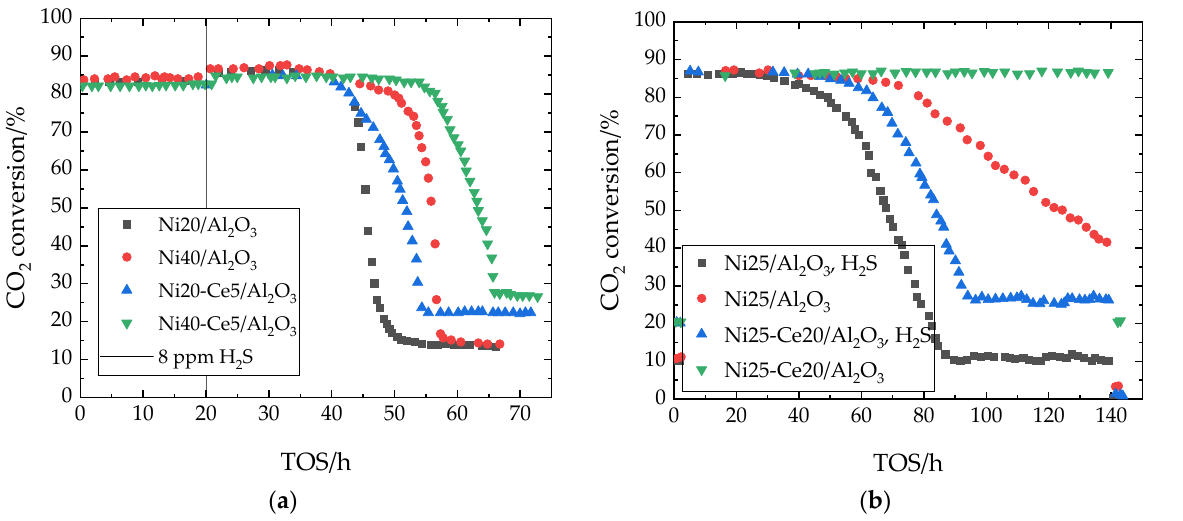
Figure 6. CO 2 conversion in H 2 S poisoning experiments in CO 2 methanation with Ce-promoted Ni/Al 2 O 3 catalysts with ( a ) 5 ppm H 2 S addition after 20 h [60] and ( b ) 1 ppm H 2 S addition compared to reference experiments